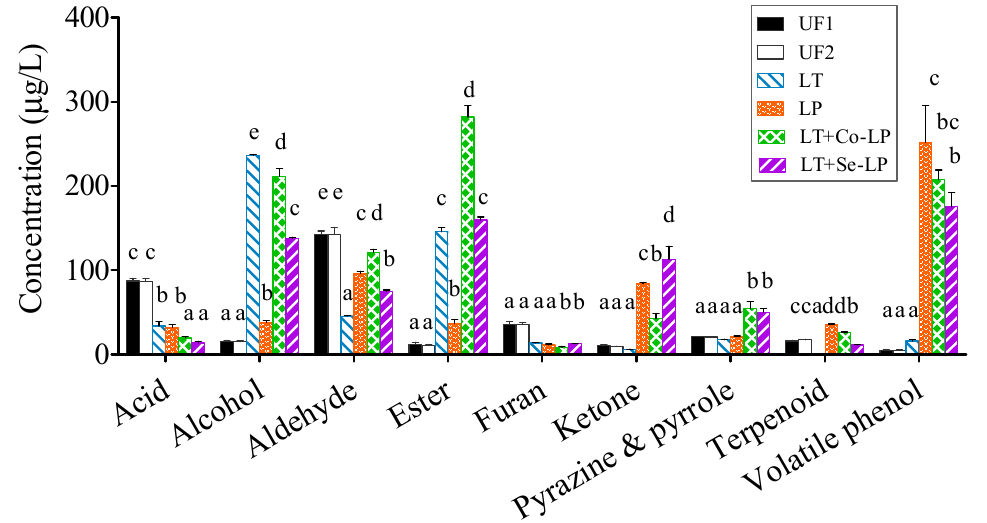
Figure 5. Subtotal contents of each type of volatiles. UF1 and UF2: Unfermented SCG hydrolysates at D0 and D14; LT: L. thermotolerans Concerto; LP: L. plantarum ML Prime; LT+Co-LP: simultaneous inoculation of L. thermotolerans Concerto and L. plantarum ML Prime; LT+Se-LP: L. thermotolerans Concerto with sequentially inoculated L. plantarum ML Prime at day 4. a, b, c, d, e: Statistical analysis using ANOVA ( n = 3) at 95% confidence interval was conducted in the same row, different letter indicated significant difference.